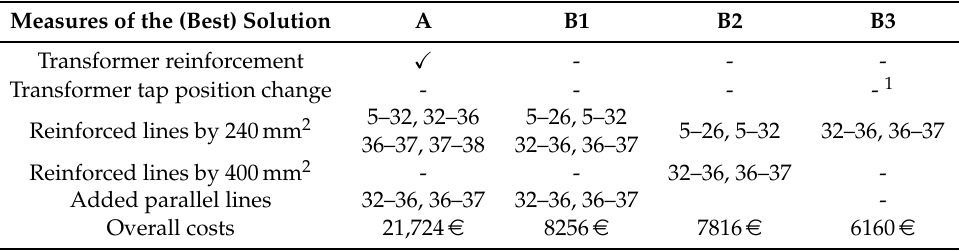
Table 3. Conclusion of the optimizations and expansions determined by the algorithms and variants.